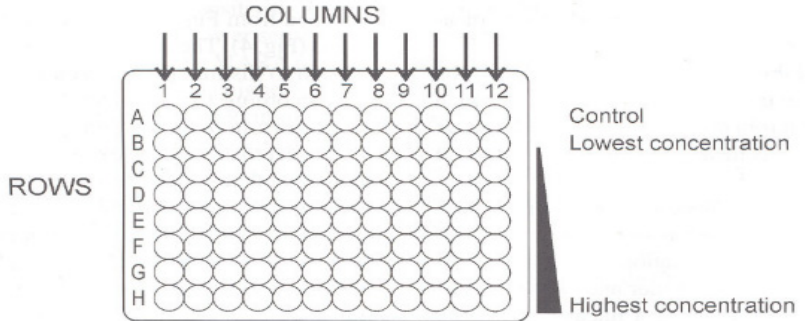
Figure 3. MARA 96-well microplate.